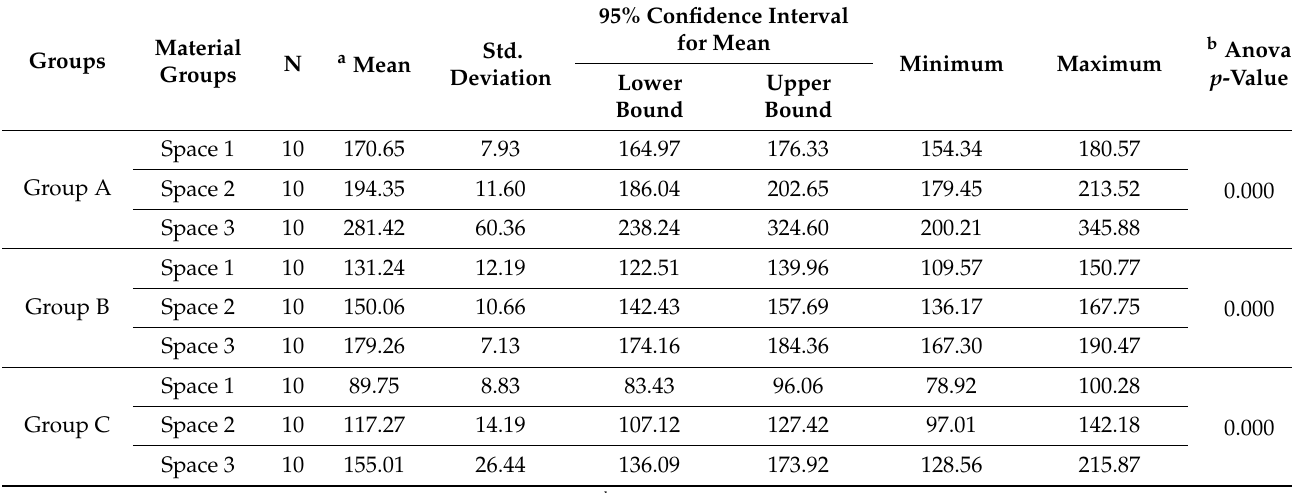
Table 4. Descriptive statistics with mean, standard deviation, and ANOVA results for the tensile bond strength.